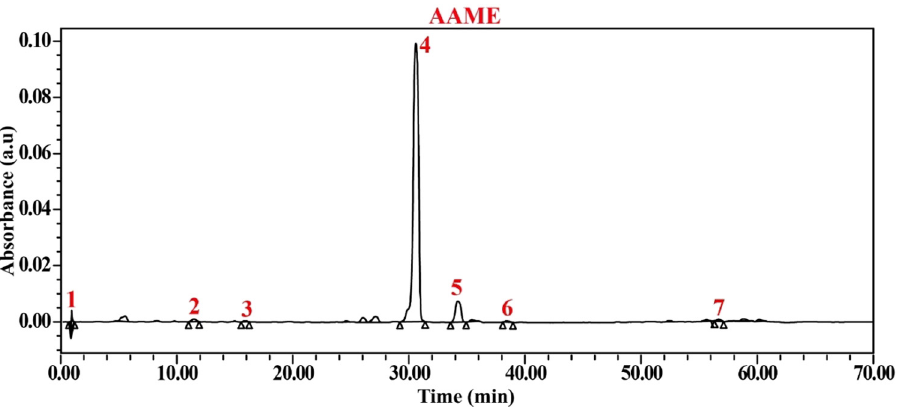
Figure 3: HPLC chromatogram of AAME. Peaks showing similar retention time to 1: gallic acid ( 0.960 min ) , 2: chlorogenic acid ( 11.479 min ) , 3: epicatechin ( 15.877 min ) , 4: rutin ( 30.591 min ) , 5: apigenin - 7 - o - glucoside ( 34.207 min ) , 6: naringenin ( 38.467 min ) and 7: chrysin ( 56.663 min ) .